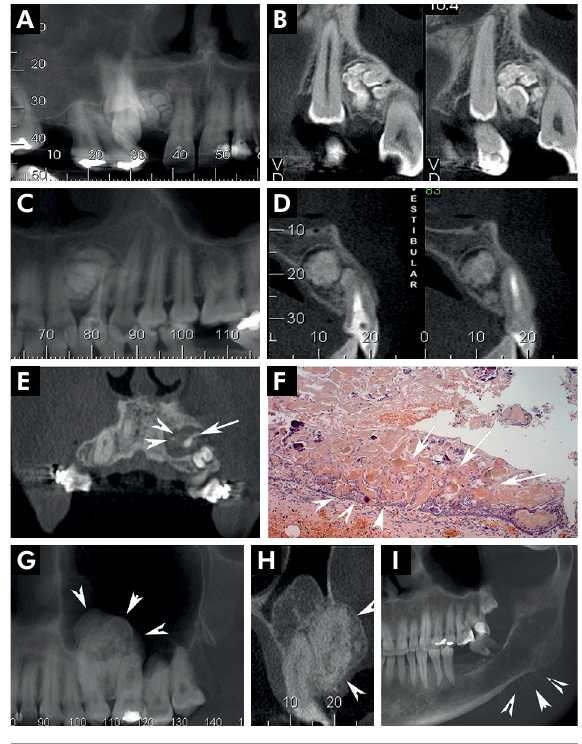
Figure 4. Compound odontoma: CBCT showing multiple hyperdense tooth-like structures lateral to the maxillary anterior tooth (A). Tooth-like structures presenting a fine radiolucent line that demonstrates a clear separation from the normal bone (B). Complex odontoma: Presence of a hyperdense amorphous structure with a thin radiolucent peripheral zone adjacent to the left maxillary lateral incisor (C-D). Calcifying cystic odontogenic tumor (CCOT): Coronal views showing a hypodense unilocular lesion with irregular hyperdense calcified structures in the periphery (arrowhead) and an associated odontoma (arrow) (E). Histopathological evaluation showing a cyst wall lined by ameloblastomatous odontogenic epithelia (arrowhead) associated with the formation of eosinophilic ghost cells (arrow) (F). Adenomatoid odontogenic tumor (AOT): In CBCT images, a mixed hypodense/hyperdense lesion is noted between the roots of the maxillary second premolar and first molar (arrow head) (G). In cross-sectional views, a preserved periodontal ligament space of the related tooth can be seen. There are also heterogenous calcified deposits in the lesion center (arrowhead) (H). In a radiographic exam, a sclerotic to a mixed radiolucent/radiopaque image in posterior mandible is observed, associated with a parosteal osteogenic reaction “sunray pattern” (arrowhead)